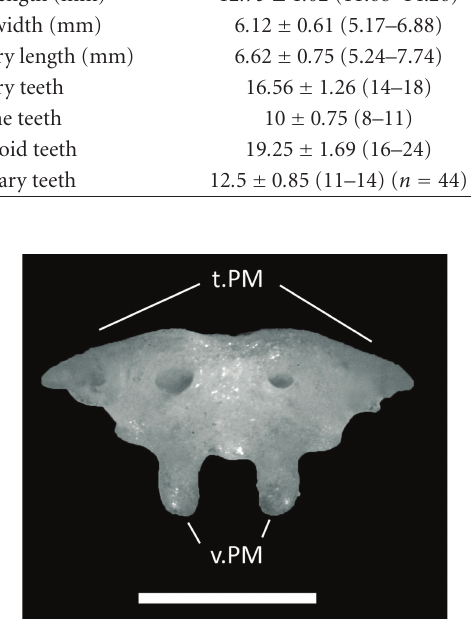
Figure 6: Ventral view of the premaxilla of Sordellina punctata (IBSP 41071). Bar = 1mm. Abbreviations other than in previous figures are t.PM: transverse process of premaxilla; v.PM: vomerine process of premaxilla.